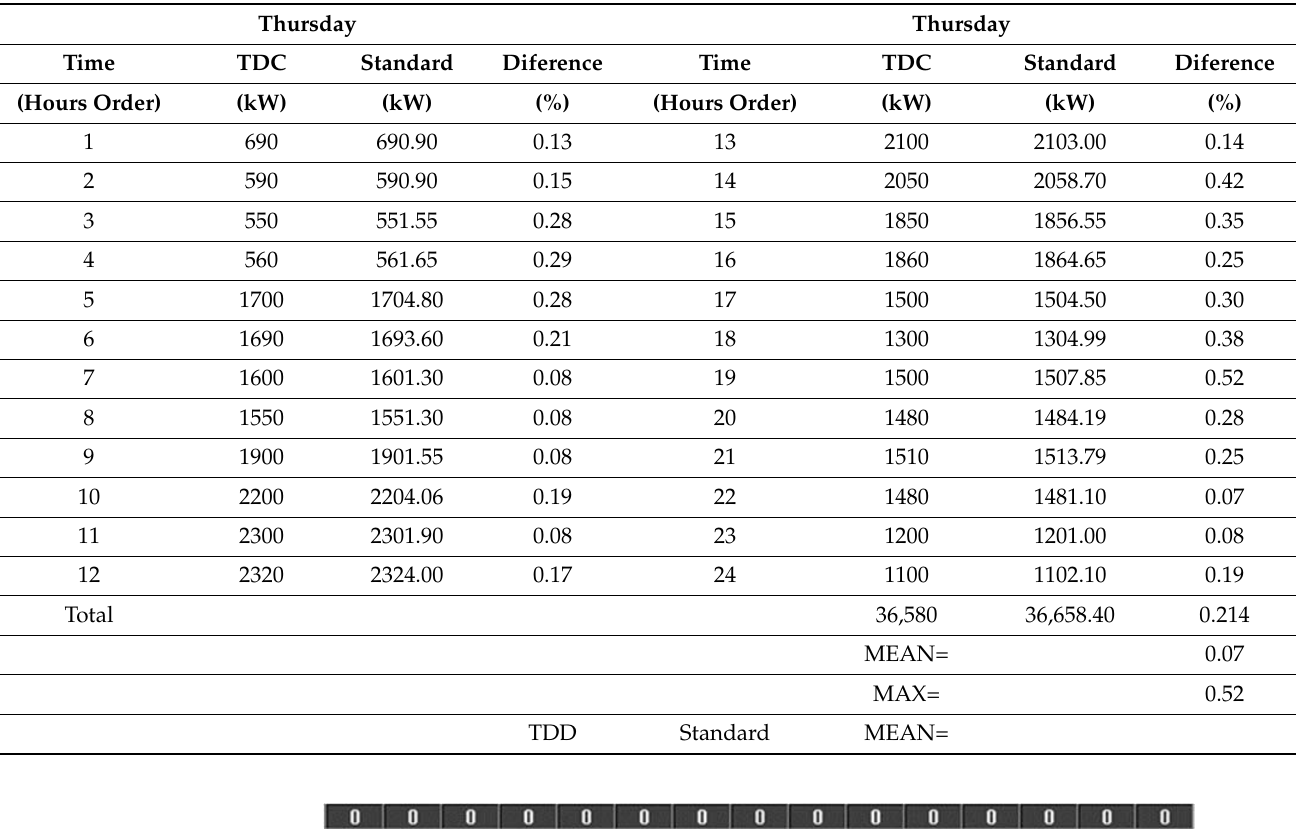
map Figure 15. From this map you can read three well-separable clusters, the highest point of the map and two less pronounced clusters probably corresponding to Saturday or Sunday and one clearly visible cluster probably representing the working day Thursday. Table 6. Comparison of consumption in standard and standard design.